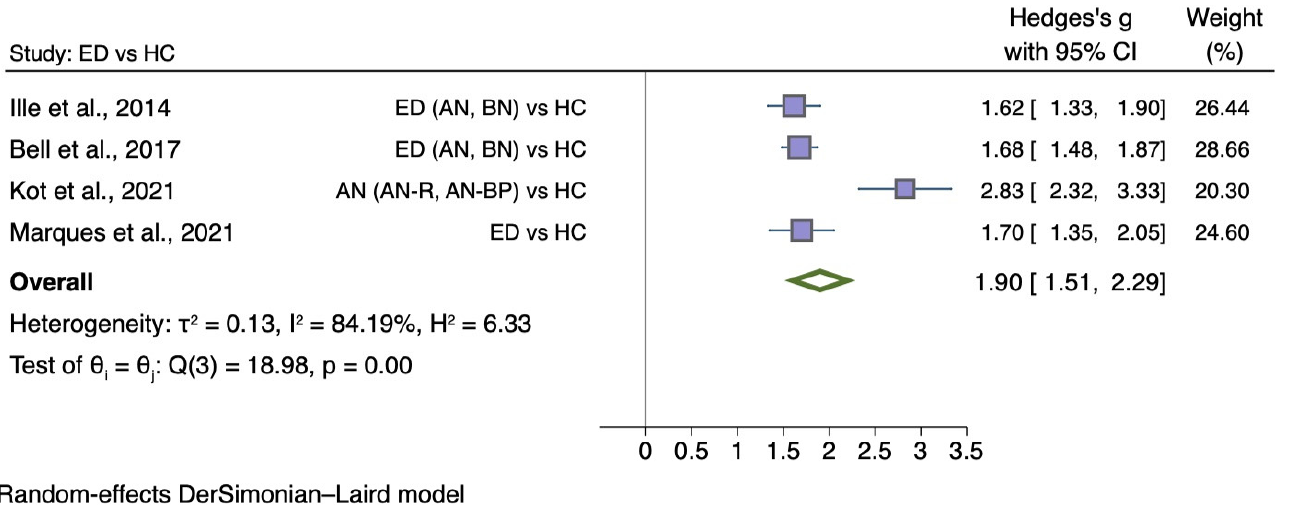
Figure 6. Forest plot of Hedges’ g in self-disgust between ED participants and HCs from n = 4 studies; CI: confidence interval. Refs.